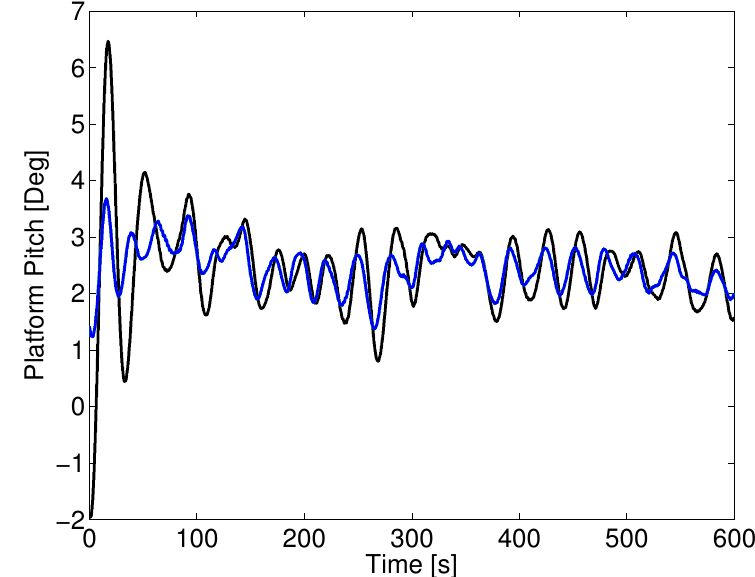
Figure 14. Perpendicular wind-wave forces with a peak wave period of 10 s: platform pitch. The blue is the LQR2 controller, while the black is the baseline.